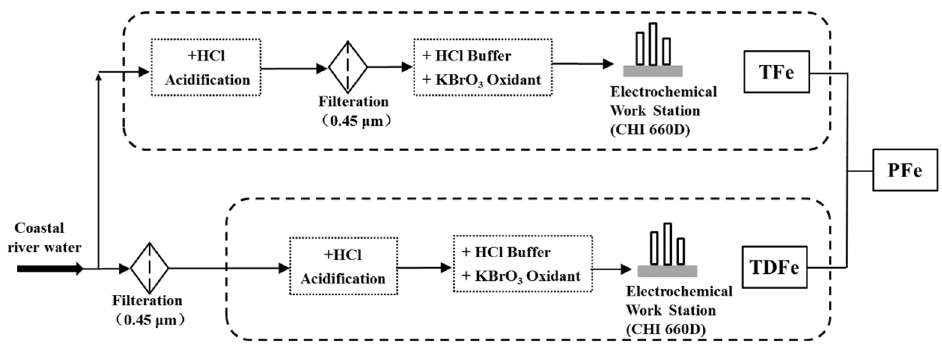
Figure 2. Process diagram for the analysis of different Fe fractions.